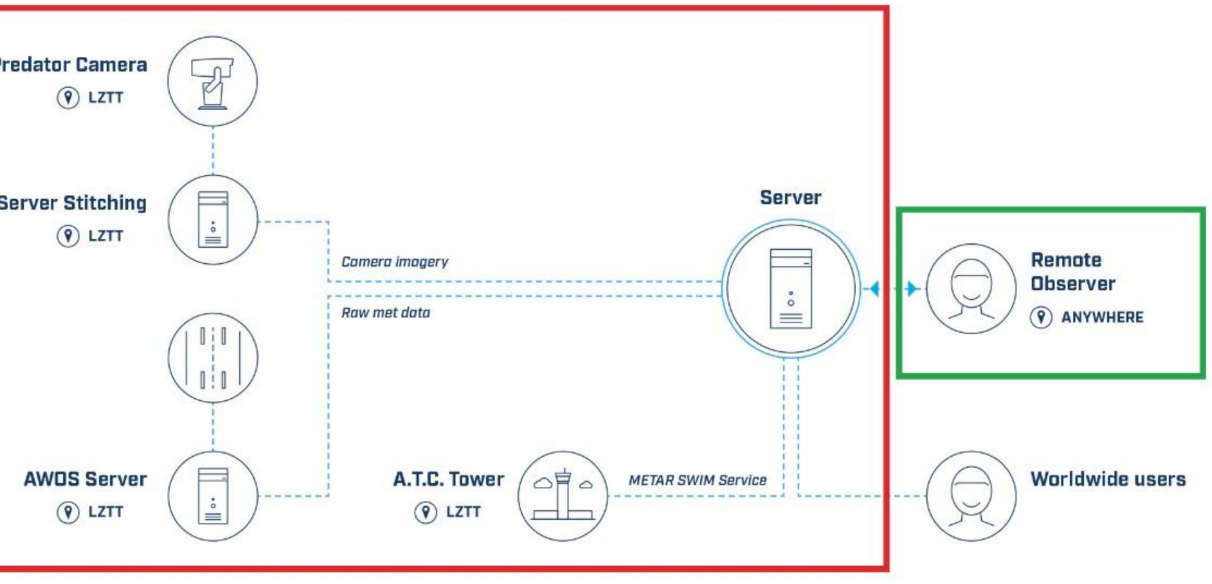
Figure 3. The structure of the proposed system, as designed at